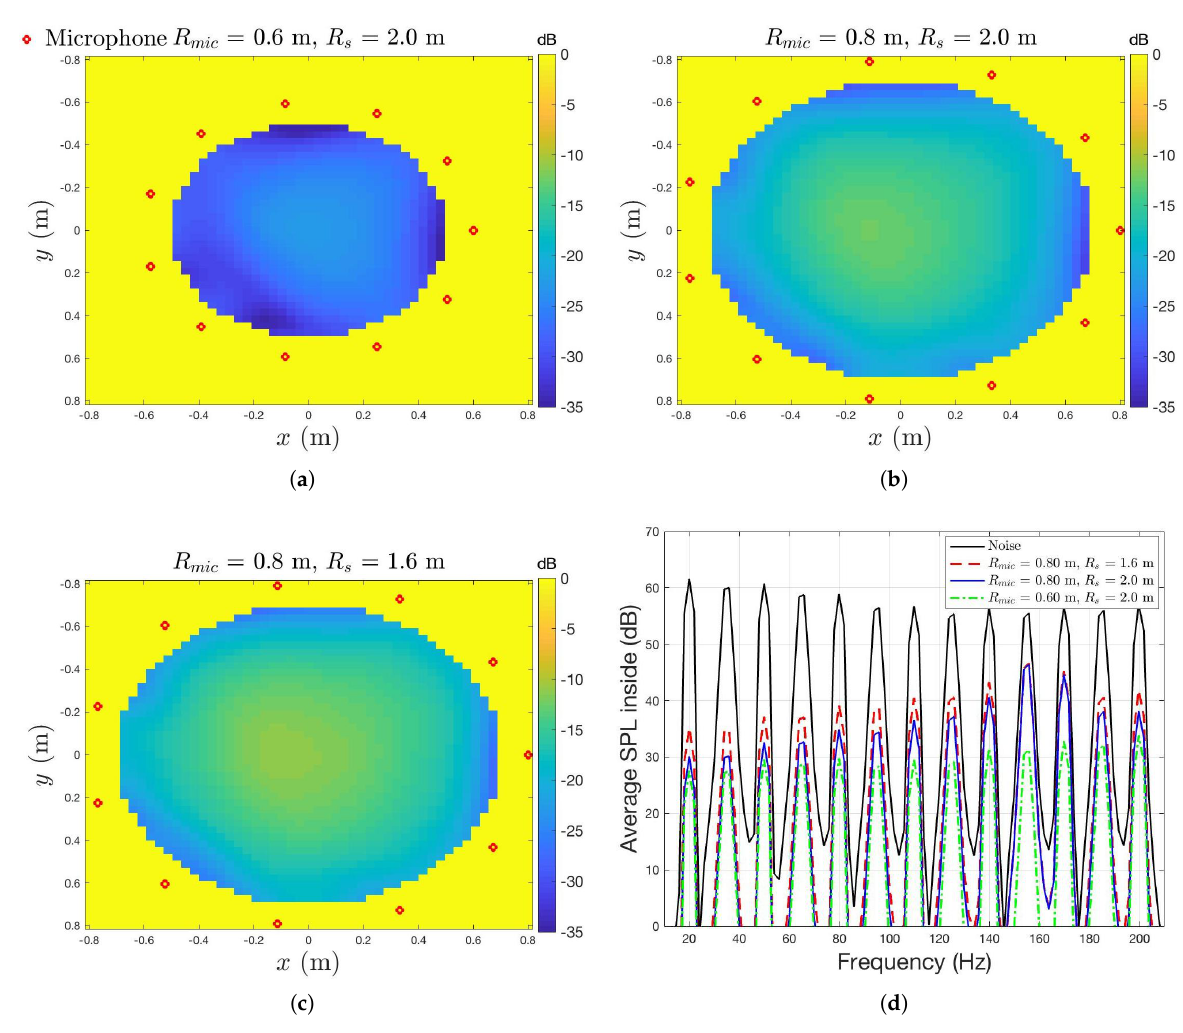
Figure 8. ( a – c ) Residual wave fields and ( d ) average noise reduction